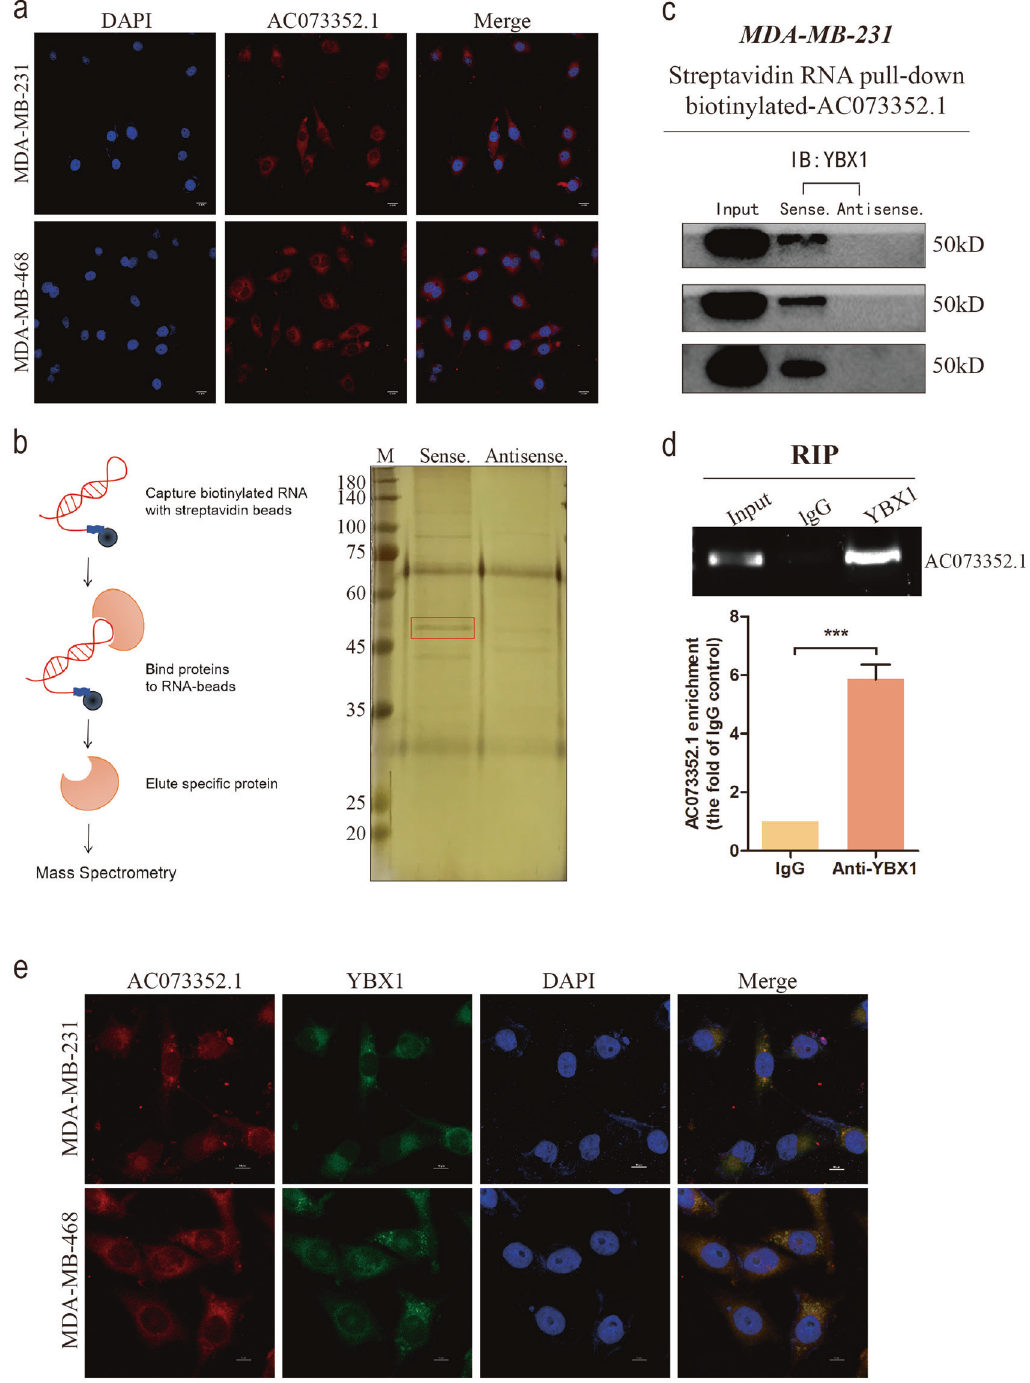
Fig. 4 AC073352.1 binds to the transcriptional activator YBX1. a AC073352.1 expression in MDA-MB-231 and MDA-MB-468 cells was detected by RNA FISH. Scale bars: 20 μ m. b AC073352.1 sense and antisense RNAs were used for in vitro transcribed and pull-down assays in MDA-MB-231 cells. After electrophoresis and silver staining, the different bans located at 45 – 60 kDa. c Western blot analysis of the speci fi c association between YBX1 and biotinylated AC073352.1; results obtained from three independent streptavidin RNA pull-down assays. d RIP assays were performed using an anti-YBX1 antibody; lgG was used as negative control. Speci fi c primers were used to detect AC073352.1 ( n = 3). e The co-localization of AC073352.1 and YBX1 was assessed by FISH and immuno fl uorescence. Scale bar: 10 μ m. *** p < investigate how AC073352.1 affects YBX1 protein stability, the expression of YBX1 in BC cells. Consistently, the results YBX1 protein levels were examined in MDA-MB-231 cells showed that the expression level of YBX1 was signi fi cantly overexpressing AC073352.1; these cells had been treated downregulated after AC073352.1 siRNA treatment in MDA-MB- with the protein synthesis inhibitor cycloheximide. As shown 468 cells, and YBX1 expression was upregulated in MDA-MB-231 in Fig. 5d, e, the protein stability of YBX1 was increased cells with AC073352.1 overexpression (Fig. 5c). To further